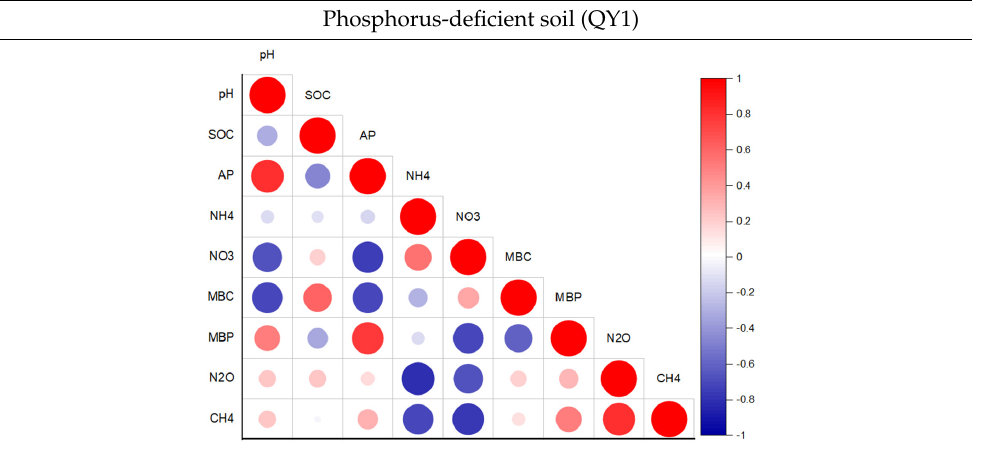
Table 3. Pearson correlation among different variables.